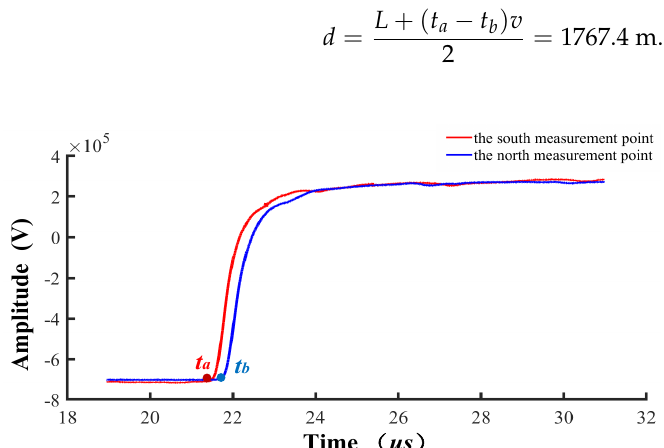
Figure 10. Expanded view of the recorded TW heads.